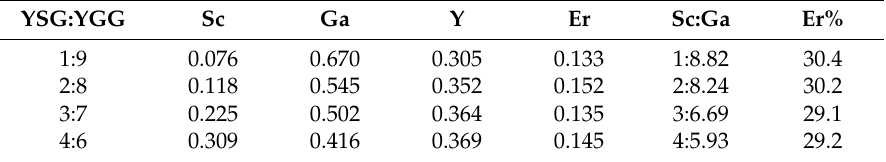
Table 2. The concentration of the Er 3+ , Y 3+ , Sc 3+ and Ga 3+ in the different samples.